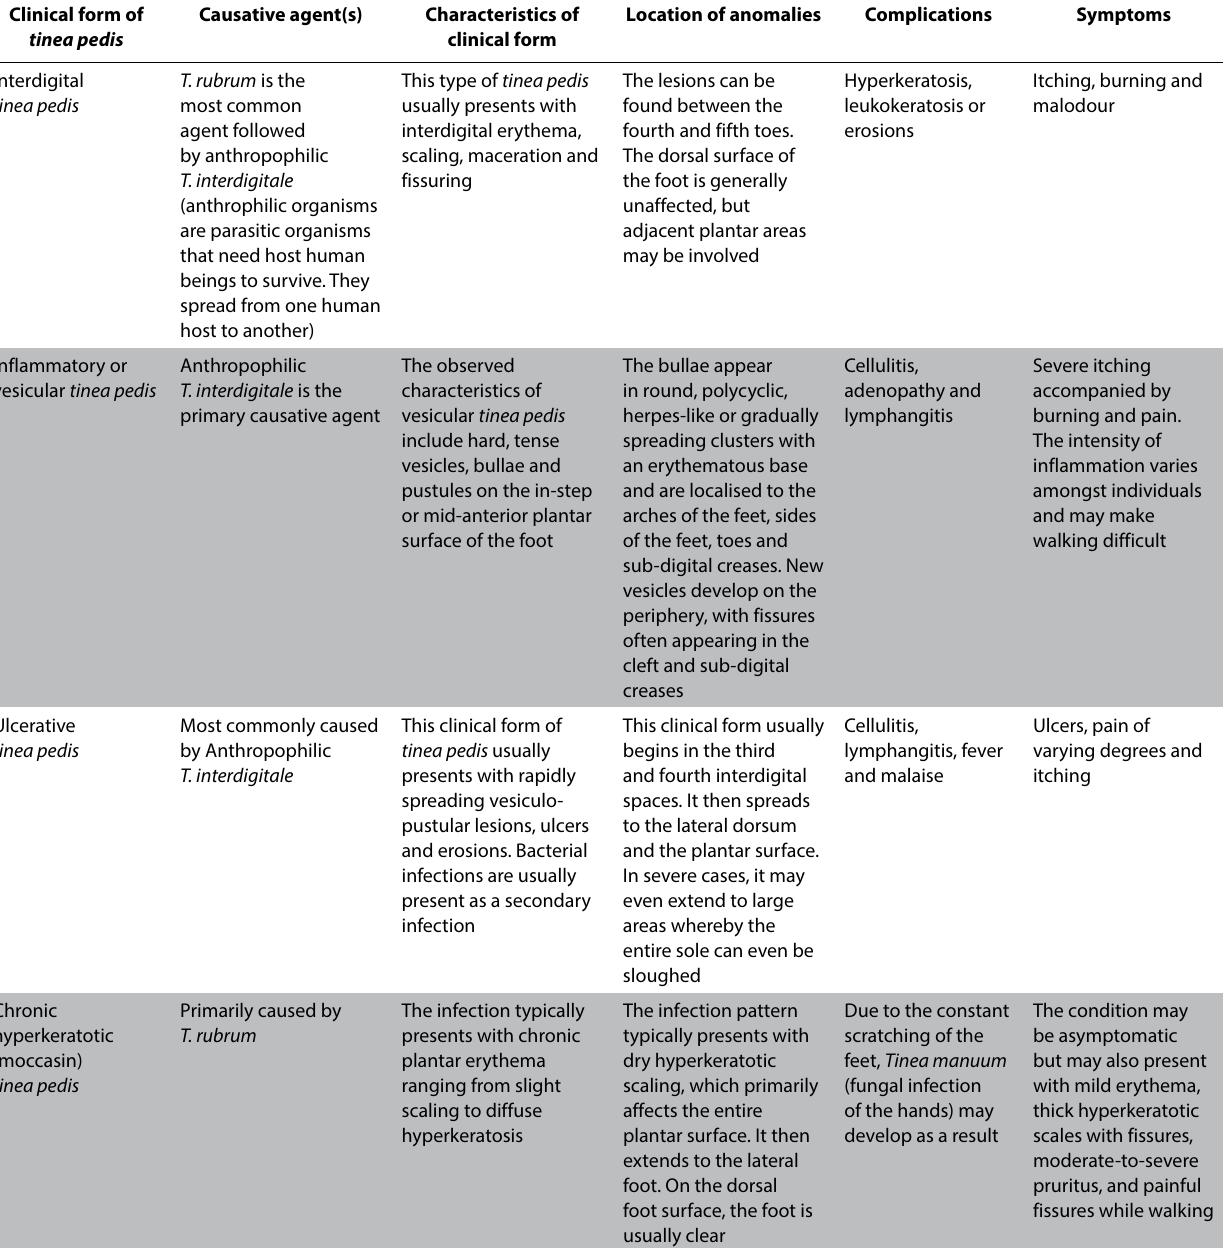
Table 1: A comparison between the various clinical forms of tinea pedis in terms of symptoms, complications, localization of the infection, characteristics that may be observed, as well as the causative agent of the infection 5,8 Clinical form of tinea